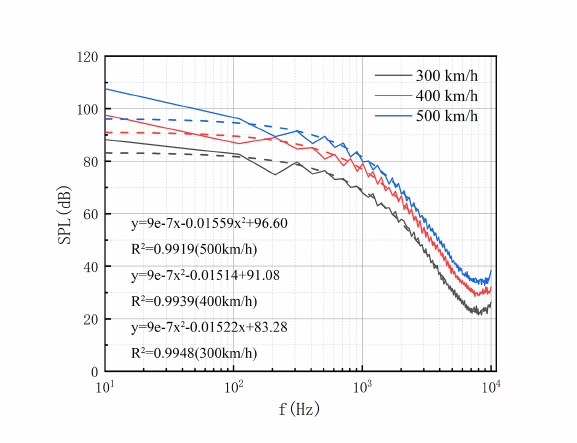
Fig. 10. Spectrum curve of sound pressure of dipole source on train